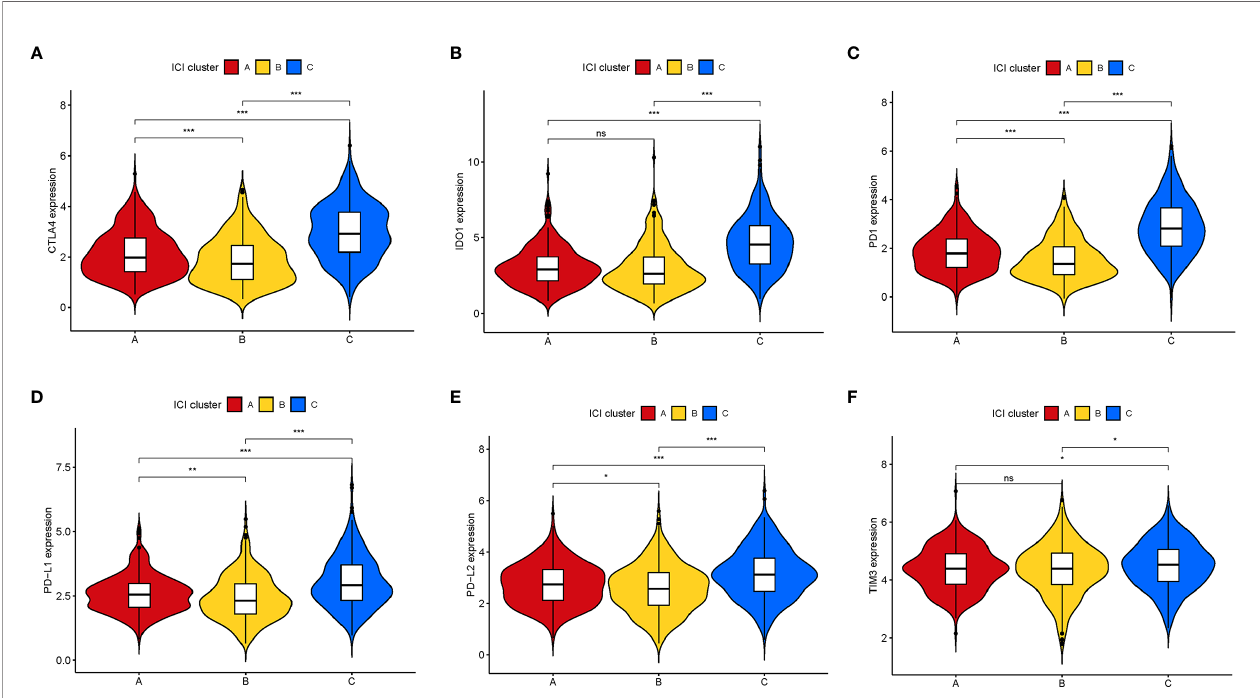
FIGURE 3 | Comparison of ICB-relevant key genes among distinct ICI clusters. The expression levels of CTLA4 (A) , IDO1 (B) , PD1 (C) , PD-L1 (D) , PD-L2 (E) , and TIM3 (F) of patients from distinct ICI clusters. The asterisks represented the statistical p value (*P < 0.05; **P < 0.01; ***P < 0.001), ns, No Signi fi